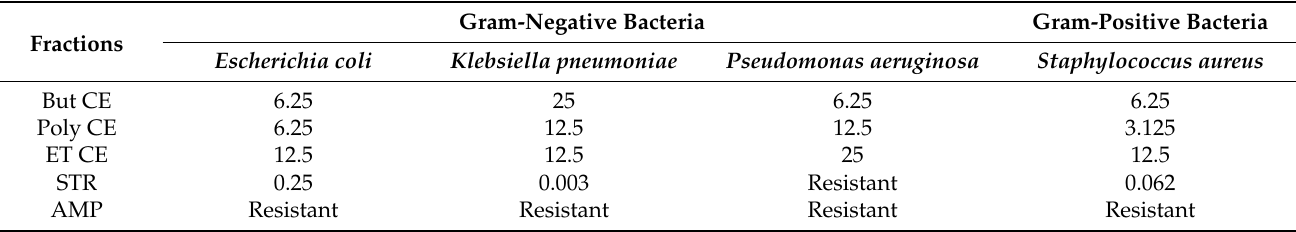
Table 5. MCI results of C. europaea fractions against bacterial species in